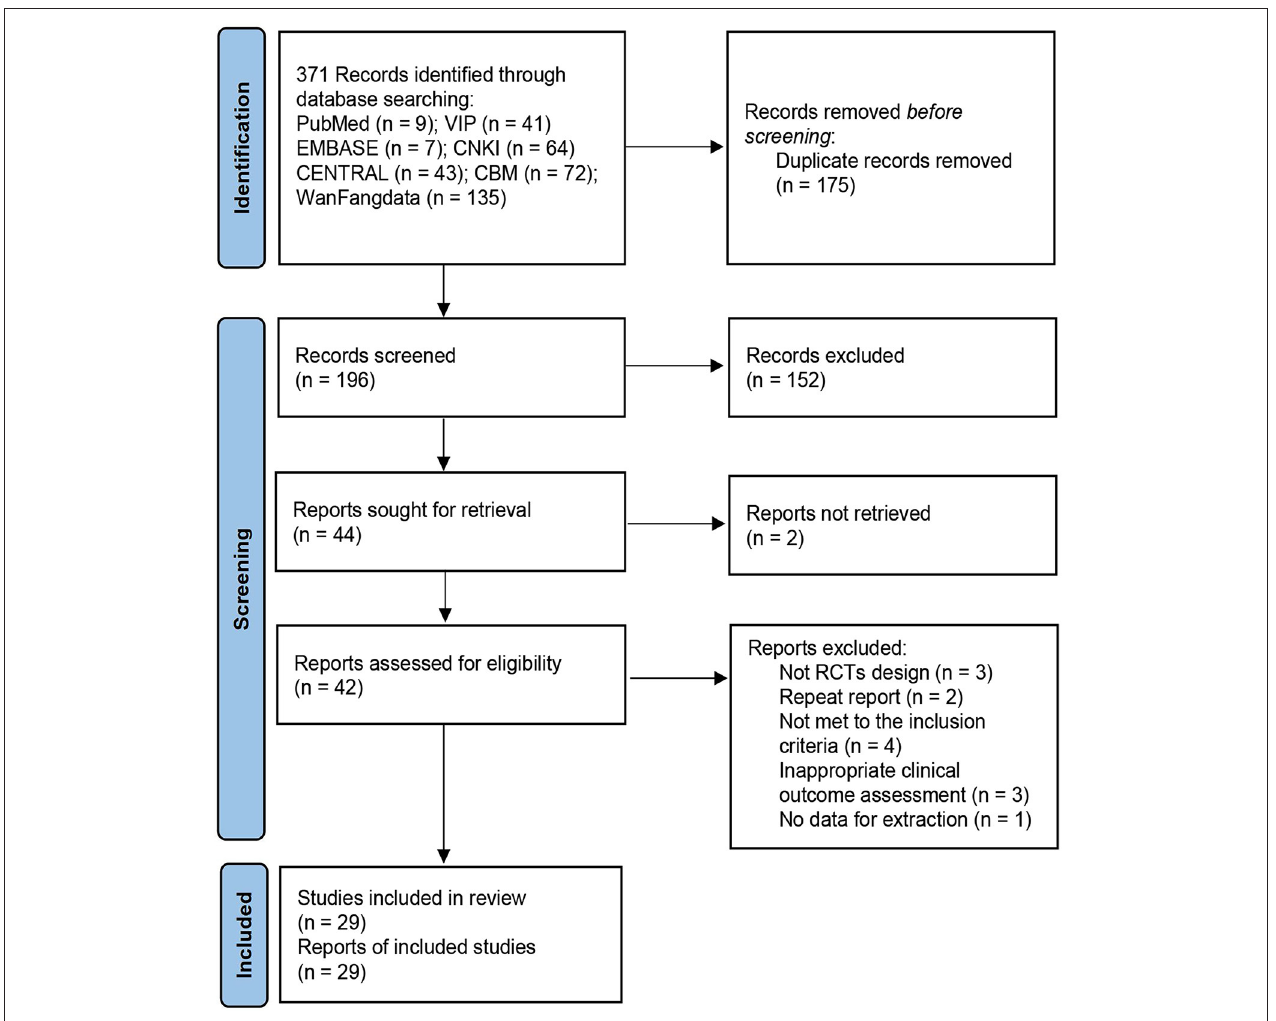
FIGURE 1 | Flowchart of study